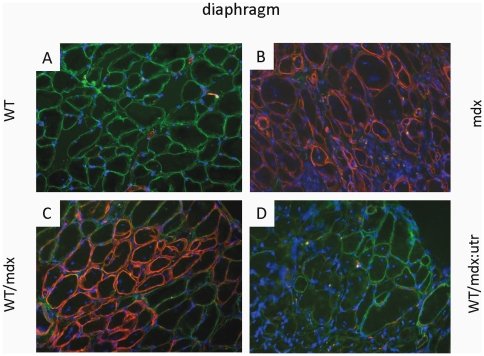
Dystrobrevin is supplied to chimeric muscle.WT (A), WT/mdx (C) and WT/mdx∶utr (D) diaphragm muscle display sarcolemma-dystrobrevin (green staining); mdx (B) and WT/mdx (C) diaphragm muscle display sarcolemma-utrophin (red staining); blue: nuclear staining (DAPI); magnification: 200×.